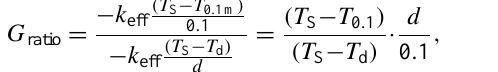
Figure 3. Debris thickness measurements on Imja–Lhotse Shar Glacier inside and outside of the melt